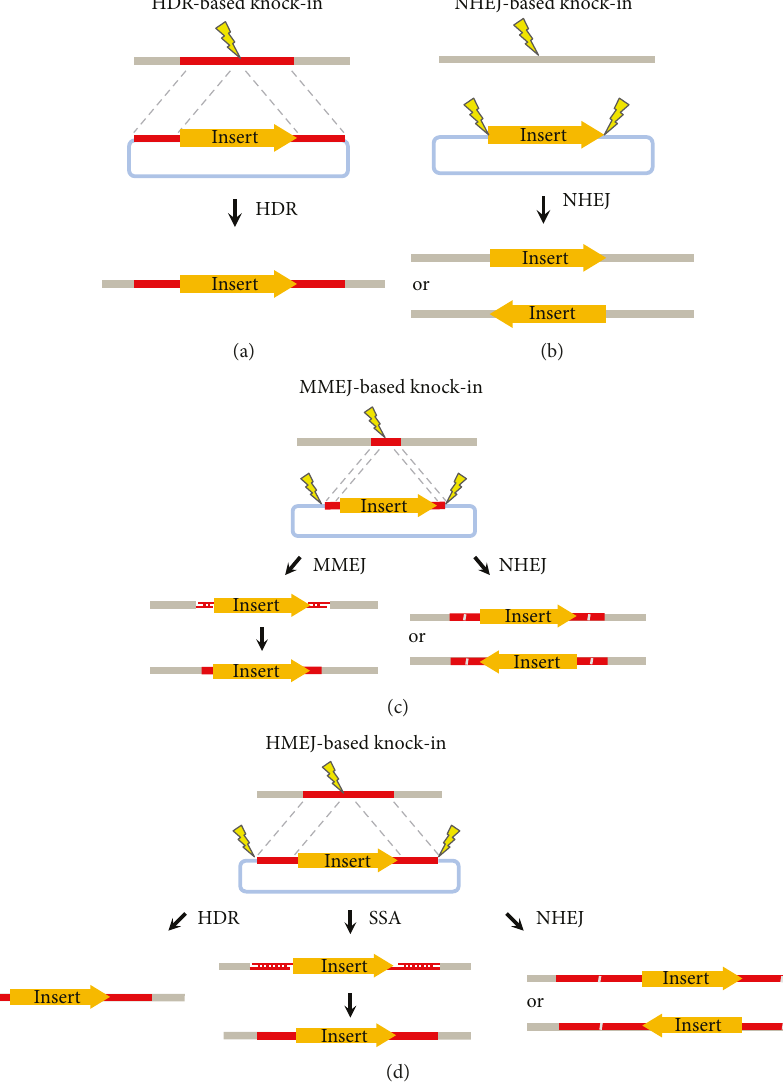
Figure 1: Schematic overview of HDR-, NHEJ-, MMEJ-, and HMEJ-based knock-in. (a) HDR-based knock-in requires long homology arms. (b) NHEJ-based knock-in, which requires the linearization of donor template rather than the homology arms. (c) MMEJ-based knock-in requires short homology arms (usually less than 50 bp). NHEJ-mediated knock-in might happen due to the presence of linearized donor template. (d) HMEJ-based knock-in requires the linearized donor template with long fl anking arms. This method may trigger HDR-, SSA-, and NHEJ-based knock-in and yield combinatory